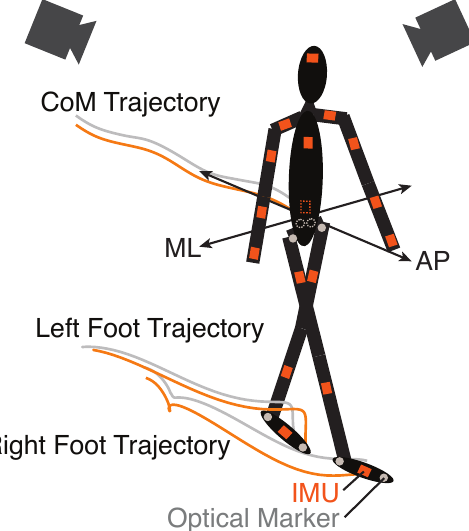
Figure 1. Experimental setup to compare inertial measurement unit (IMU) and Optical measurements. Participants wore an IMU motion-capture suit with seventeen IMUs (orange squares) and eight Optical markers (grey circles) as they walked overground. Exemplar trajectories of the center of mass (CoM) position and each foot are shown for one gait cycle (IMU—orange, Optical—grey). Mediolateral (ML) and anterior-posterior (AP) directions are